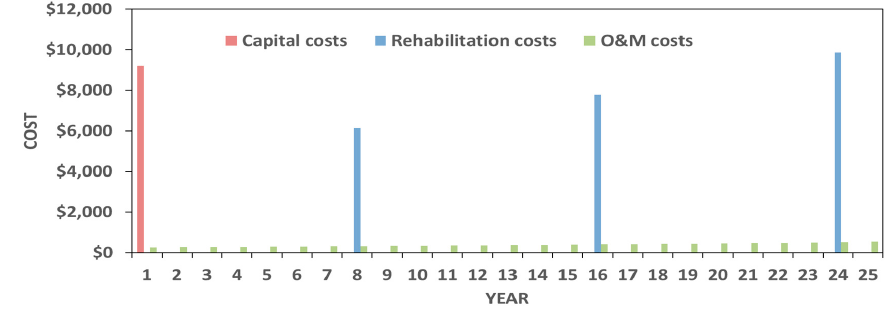
Figure 8. Effective percentage of each cost component over 25 years lifetime of project. Table 3. Cost categories during the life cycle of the project.